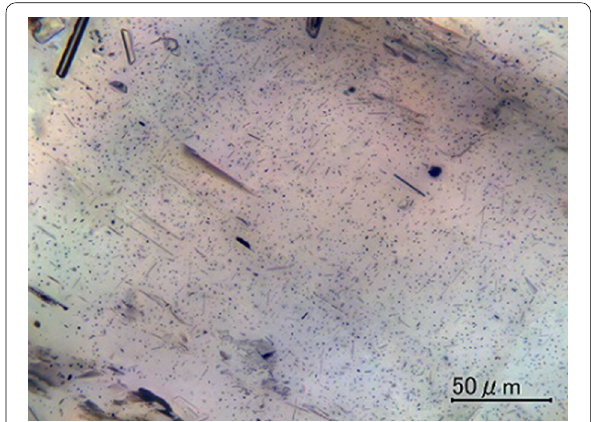
Fig. 7 Microscopic image of a polished single plagioclase crystal. Stacking of snaps of different focal